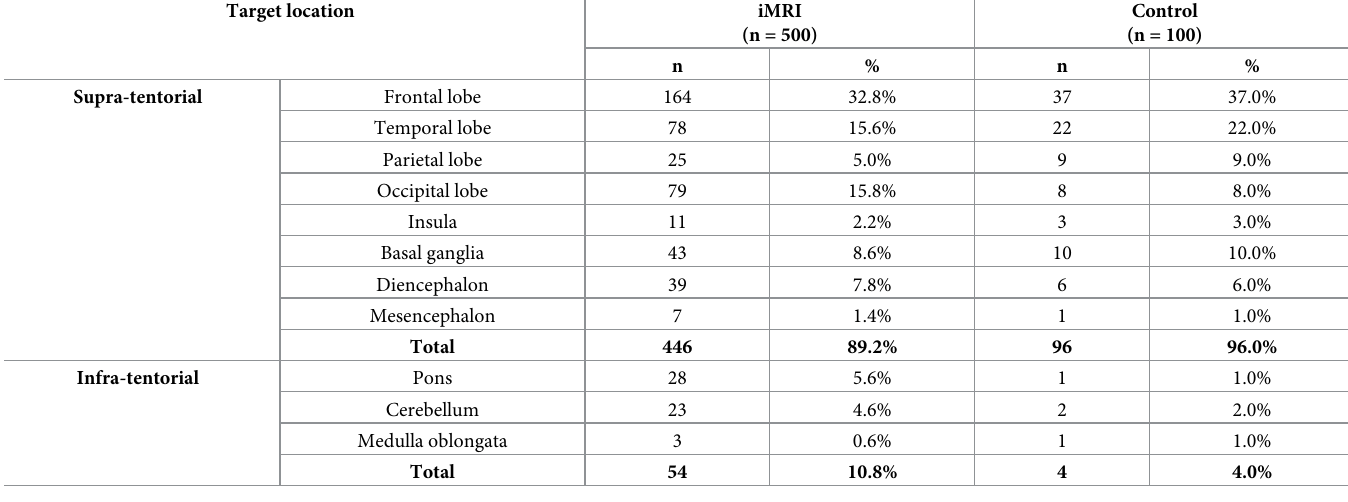
Table 2. Location of biopsy